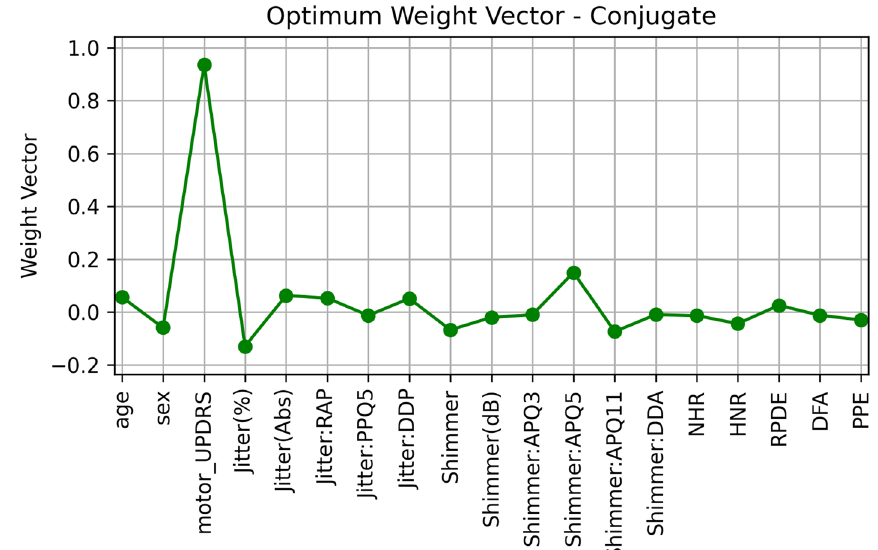
Fig. 9 Optimized weights for conjugate gradient